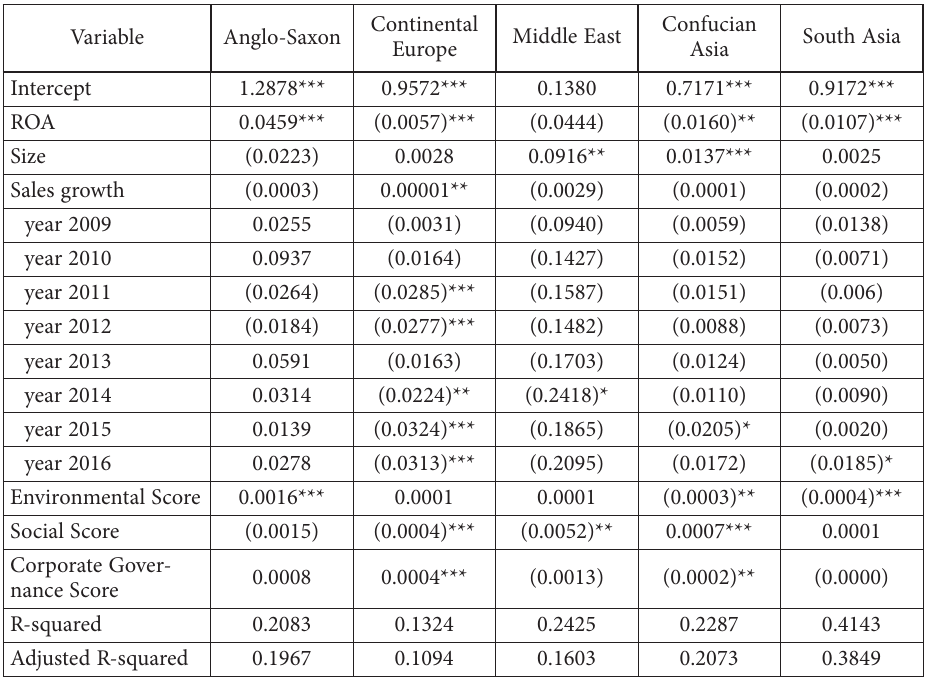
Table 4 and 5 present regression results for Model 1 and 2, respectively with regard to each cultural group associated with banks’ origin in BS. Table 4. Regression results for Tobin’s q – cultural groups